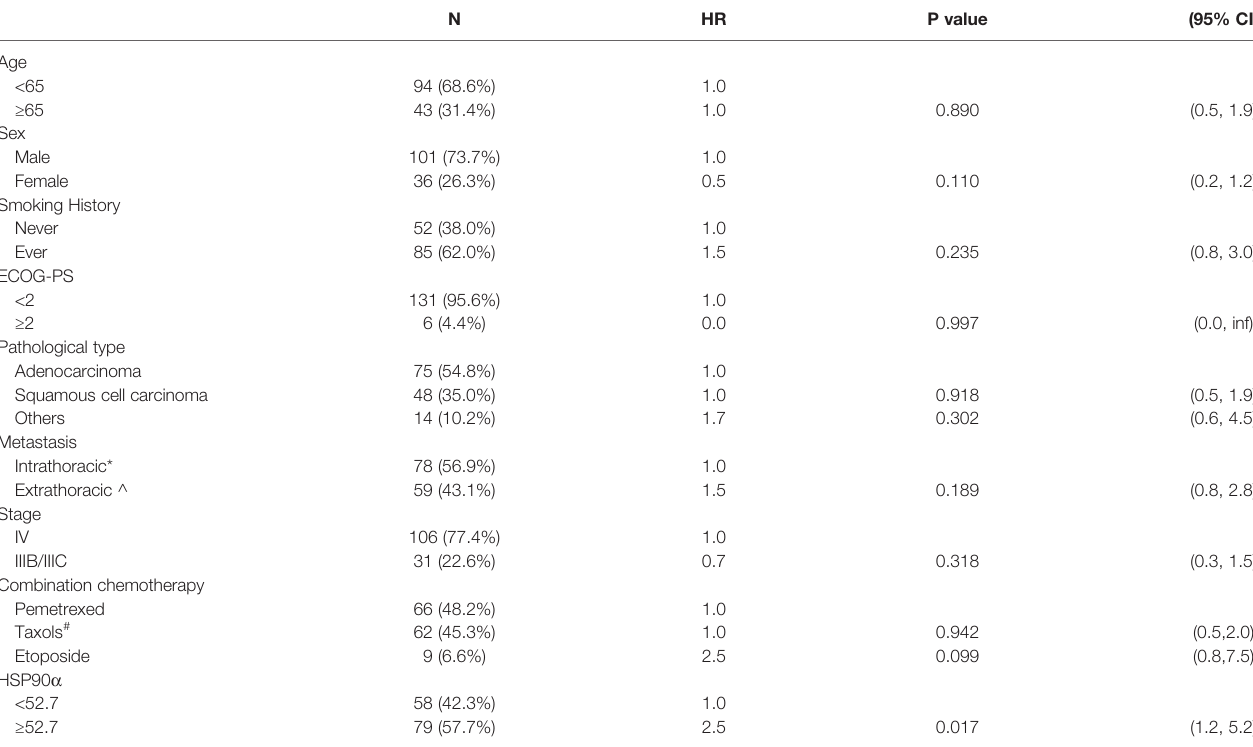
TABLE 3 | Univariate Cox regression analysis of the possible predictive factors for OS.